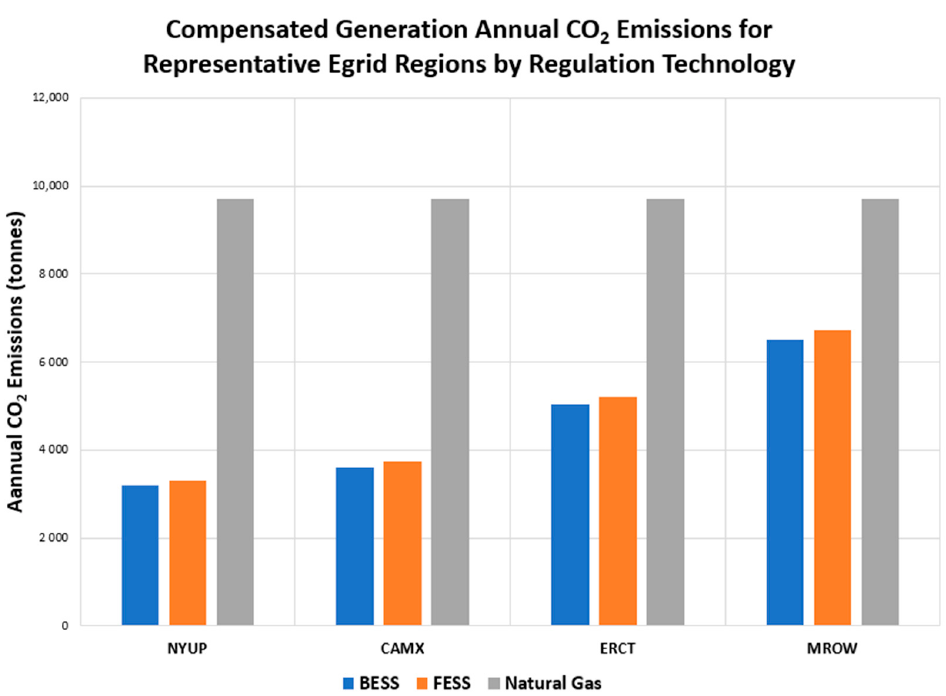
Figure 2. Annual CO 2 emissions with compensated generation when providing Reg A frequency regulation service for upstate New York (NYUP), California (CAMX), Texas (ERCT), and the upper Midwest (MROW). The battery energy storage system (BESS) and flywheel energy storage system (FESS) emissions are similar for all regions with the BESS having slightly lower emissions. The ESS has lower CO 2 emissions than the compensated generation natural gas plant in all eGRID subregions.